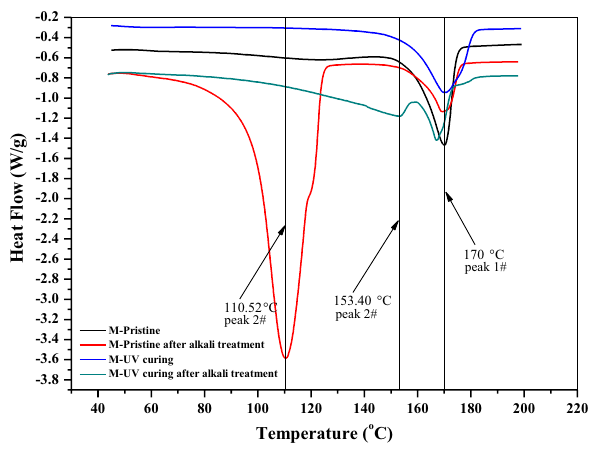
Fig. 7 DSC curves of NaOH-treated and untreated pristine PVDF membranes and UV-curable resin-modified PVDF